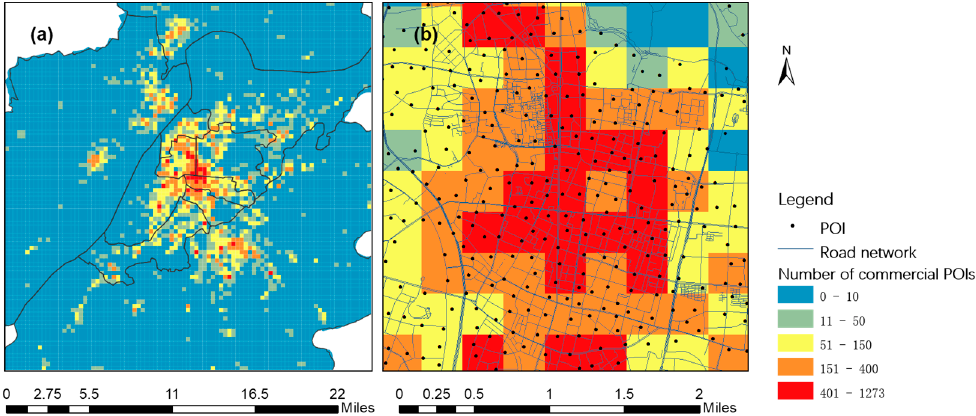
Figure 5. Illustration of commercial POI distribution: ( a ) spatial distribution density of commercial POIs and ( b ) detailed map of some commercial POI distributions.